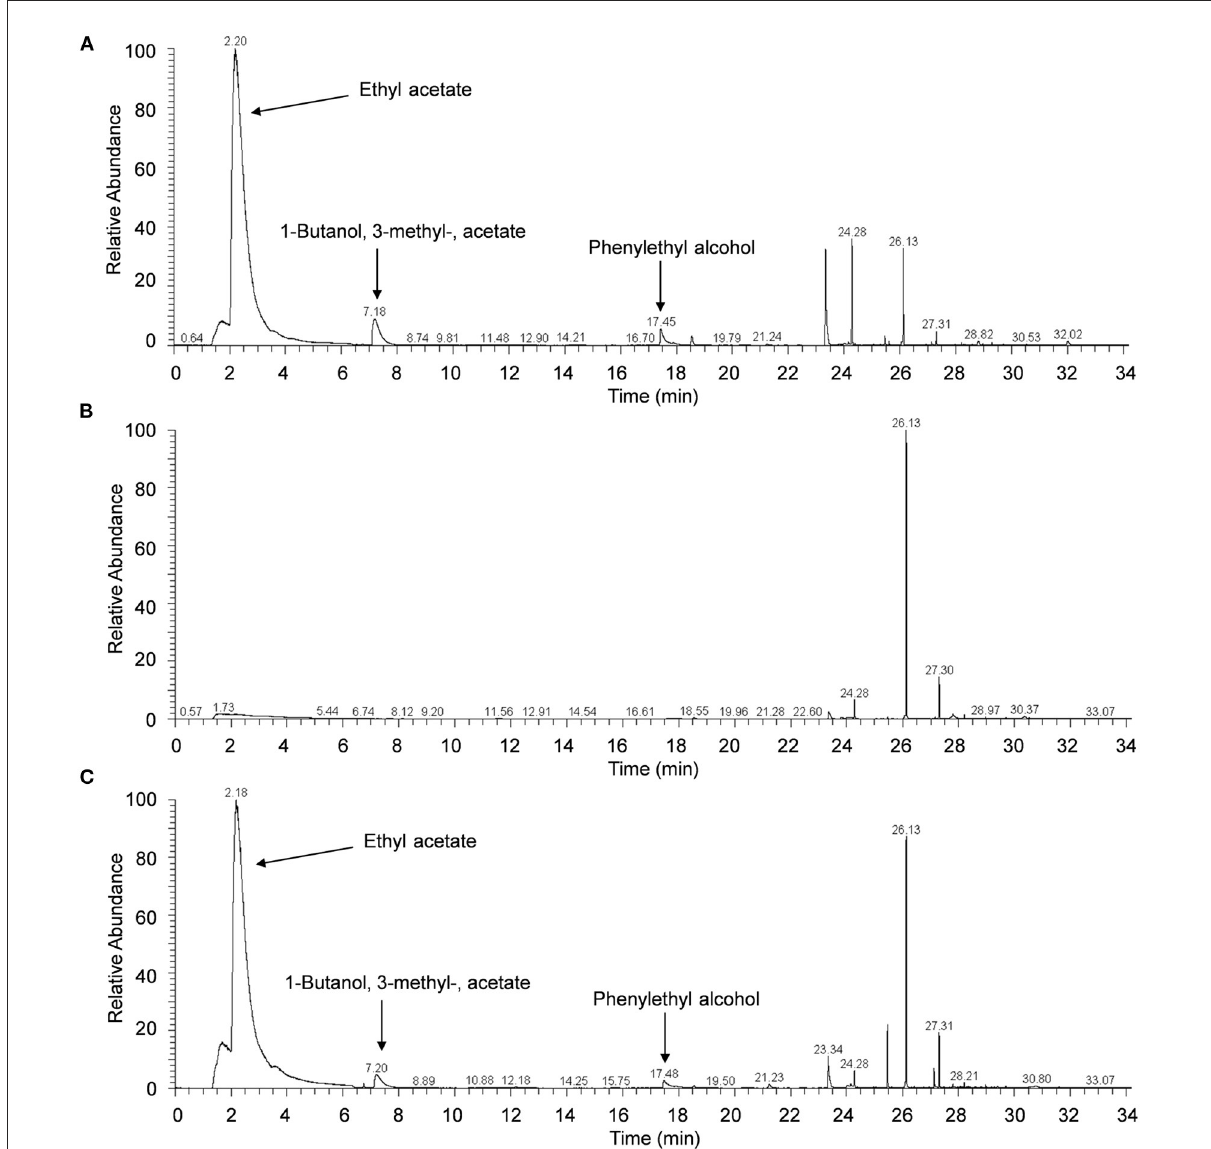
FIGURE4 Chromatograms of VOCs. (A) The VOCs released from H. uvarum MP1861. (B) The VOCs produced by P. nicotianae FQ01. (C) The VOCs produced by coculture of the yeast and oomycete.